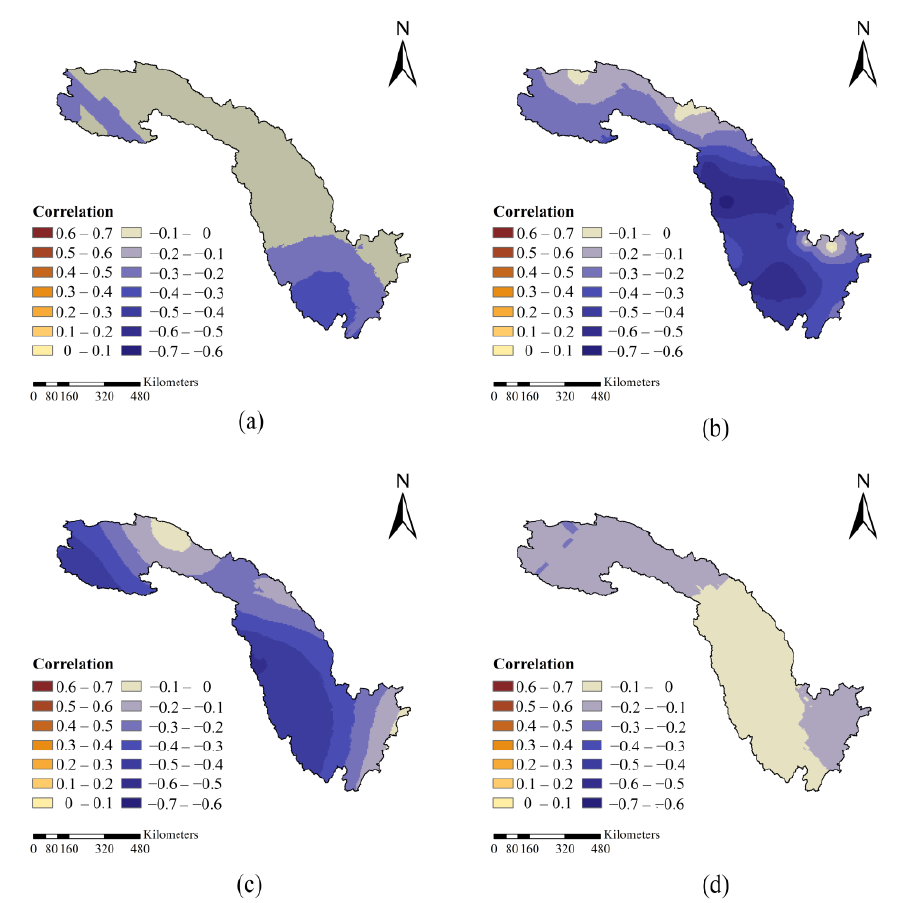
Figure 14. Spatial distribution of the correlation between seasonal maximum temperature and precipitation in the ( a ) spring, ( b ) summer, ( c ) autumn, and ( d ) winter.